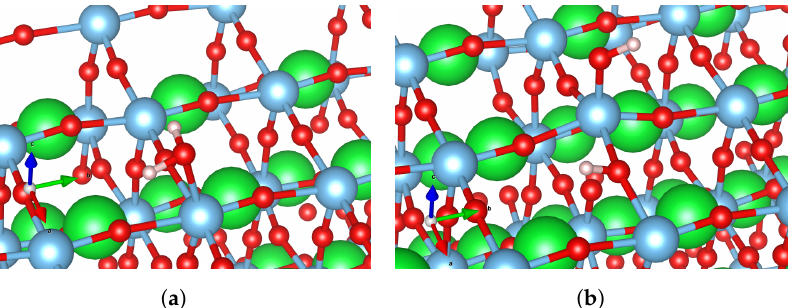
Figure 3. Water adsorption configuration on the stepped surface. ( a ) Molecular adsorption on the flat surface: E ads = − 0.79 eV. ( b ) Dissociative adsorption on the flat surface: E ads = − 1.09 eV.